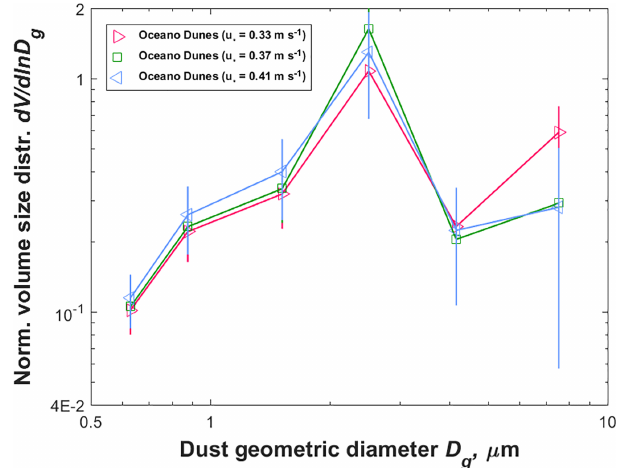
Figure 4. Shear velocity dependence of the normalized volume par- ticle size distribution of dust at emission at Oceano. We divided the measurements evenly into three shear velocity bins, with averaged values of 0.33, 0.37, and 0.41ms − 1 , respectively. Error bars on the measurements were obtained through error propagation (details in